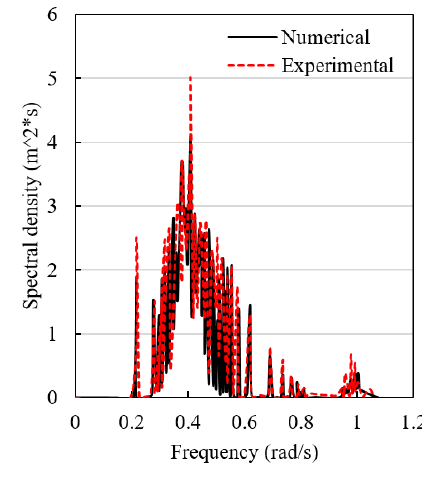
Figure 6. Surge motion of the CALM buoy.